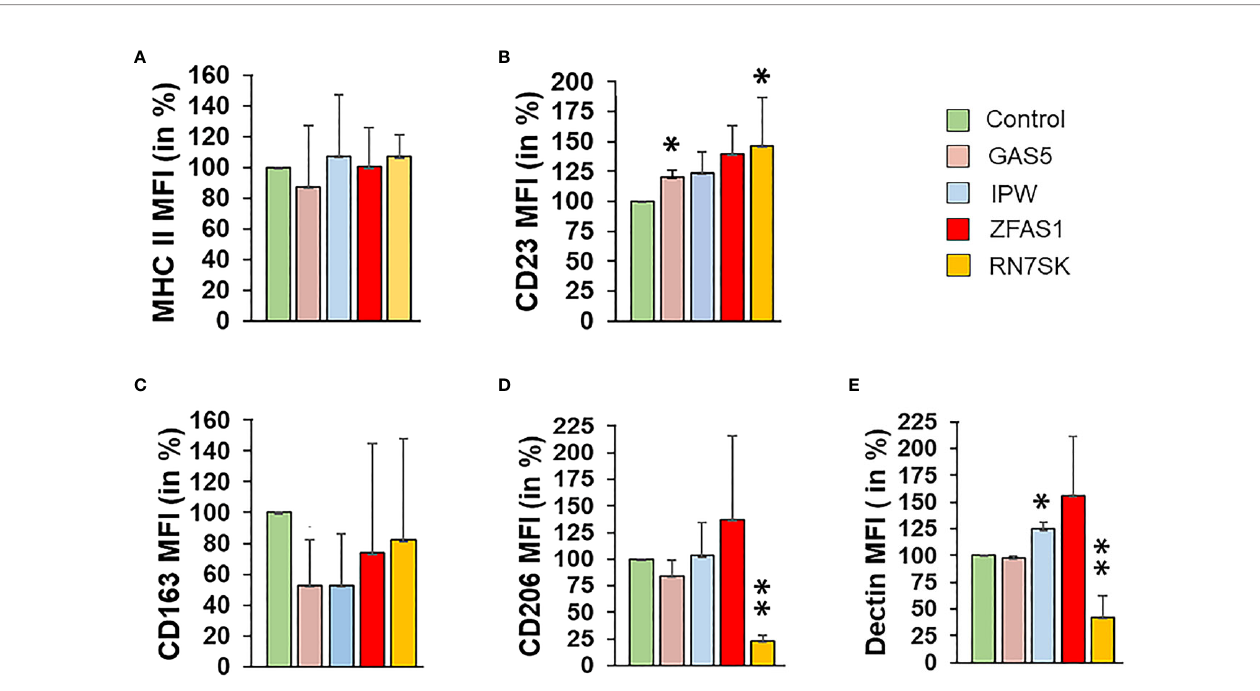
FIGURE 2 | Knockdown of RN7SK and GAS5 skew macrophage polarization by suppressing M2 phenotype markers. Day 3 M2 macrophages were transfected with 100 nM siRNA targeting GAS5, IPW, ZFAS1, RN7SK or scramble control. After 72 h, the effect of lncRNA knockdown on the expression of (A) MHC II, (B) CD23 (surface markers for M1 M j ), (C) CD163, (D) CD206 and (E) Dectin (surface markers for M2 M j ) was assessed by fl ow cytometry. Histograms showing percent geometric mean fl uorescence intensity (Geo. MFI) for fi ve different polarization markers after lncRNA knockdown. Data are mean ± SEM of three independent experiments (n = 3). Two-tailed t-test was used to evaluate the statistical signi fi cance compared to control siRNA. *P < 0.05, **P < 0.01